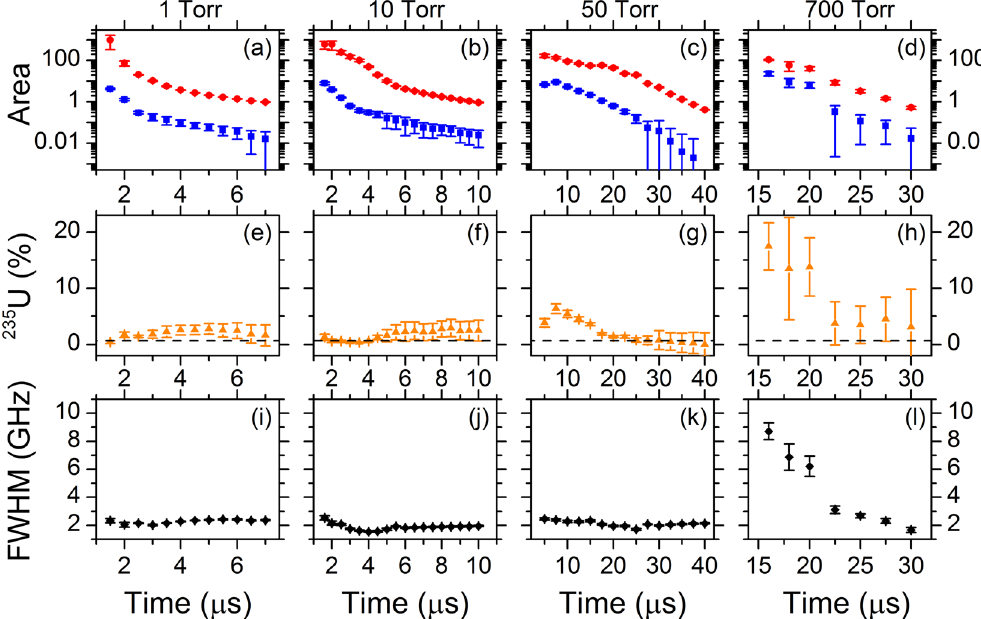
Figure 5. Time-dependence of fit parameters from TRAS of NU sample. Columns show results for 1, 10, 50, and 700 Torr Ar. Error bars are calculated from standard errors of the fit parameters. ( a – d ) Areas of 238 U (red) and 235 U (blue) peaks. ( e – h ) Isotope ratio of 235 U calculated from areas of peaks. Dashed line shows expected isotope ratio of 0.7% 235 U. ( i , j , k , l ) Voigt width